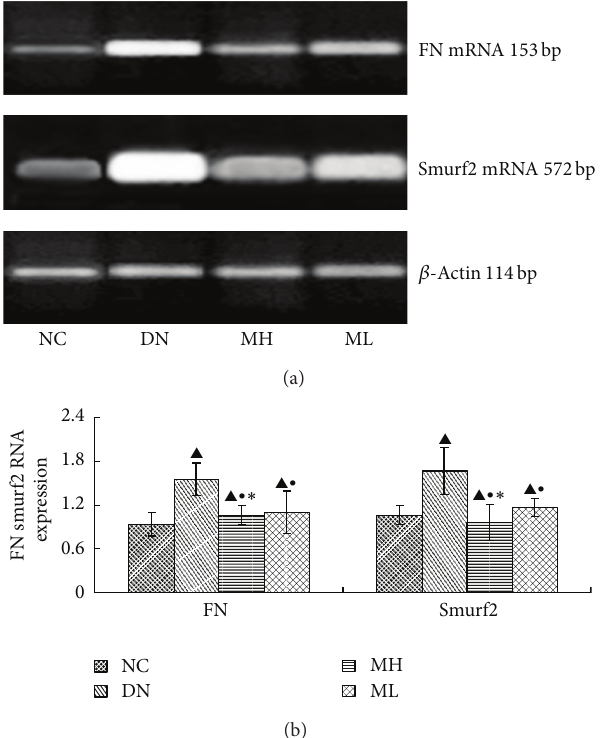
Figure 5: FN and Smurf2 mRNA levels by real-time fluorescent quantitative PCR in each group. (a) RT-PCR strip chart. (b) The gray graph shows the relative statistical values of the mRNA levels. Compared with the NC group, the levels of FN mRNA and Smurf2 mRNA increased in each experimental group, especially in the diabetic nephropathy group, but subsequently decreased in the MH andMLgroupscomparedwiththediabeticnephropathygroup,with a more significant decrease in the MH group compared with the ML